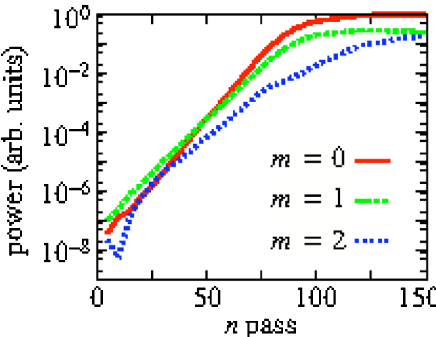
FIG. 5. (Color) Example of supermode growth for the lowest three order modes obtained from a 2D GINGER simulation of the 12-keV FEL in Table I. The transverse field is projected onto the Gaussian cavity mode, thereby allowing a 1D supermode analy- sis. Note how the m ¼ 1 mode initial dominates, but the radia- tion evolves to be nearly Gaussian because of better coupling to the m ¼ 0